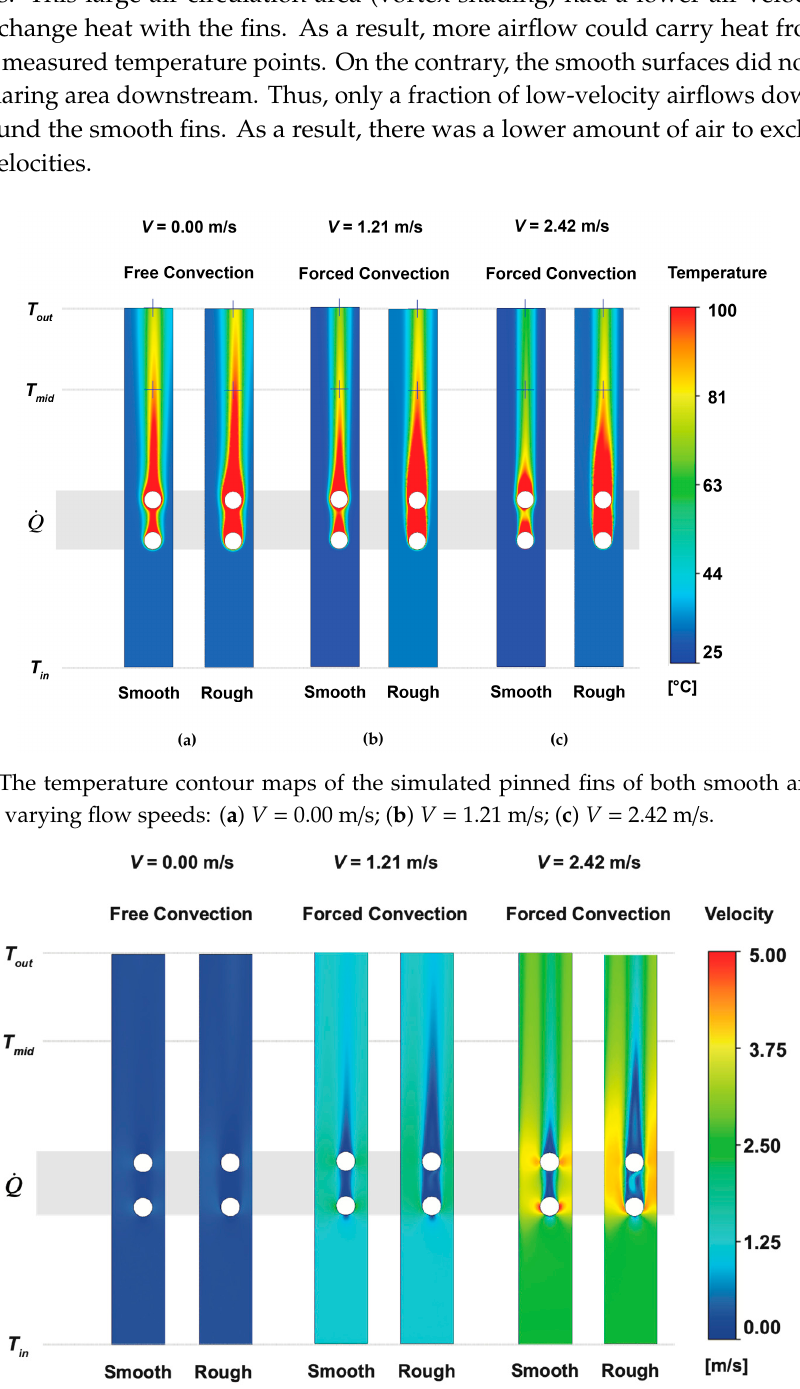
Figure 8. The velocity contour maps of the simulated pinned fins of both smooth and rough surfaces at varying flow speeds: ( a ) V = 0.00 m/s; ( b ) V = 1.21 m/s; ( c ) V = 2.42 m/s.